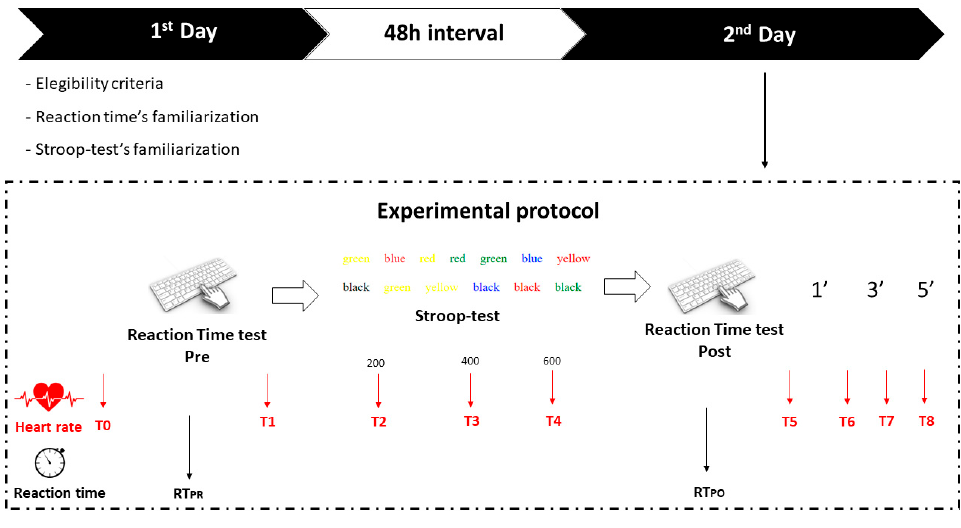
Figure 1. Study Figure 1. Study design.